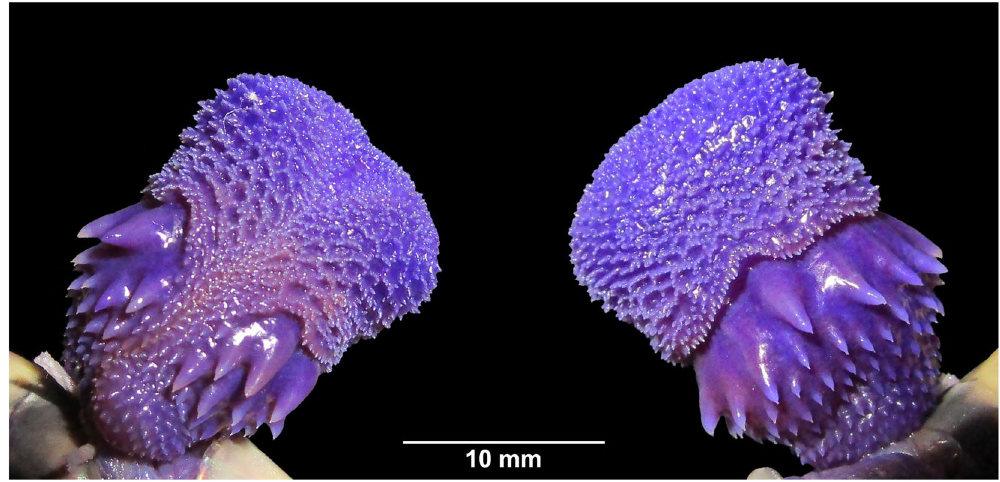
Figure 5. Sulcal (left) and asulcal (right) views of the right hemipenis of Bungarus fasciatus sensu stricto (MZMU2935) from Mizoram,